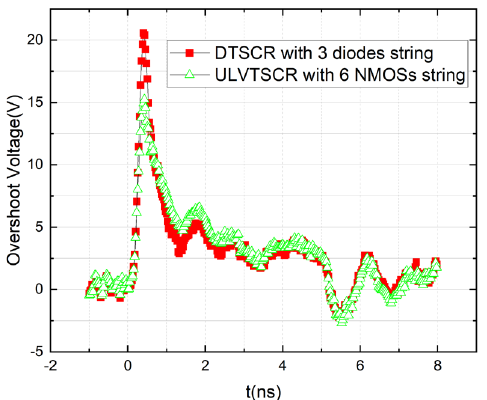
Figure 5. VFTLP waveforms measured at a current of 1.5 A for the 3-string DTSCR and 6-string ULVTSCR.